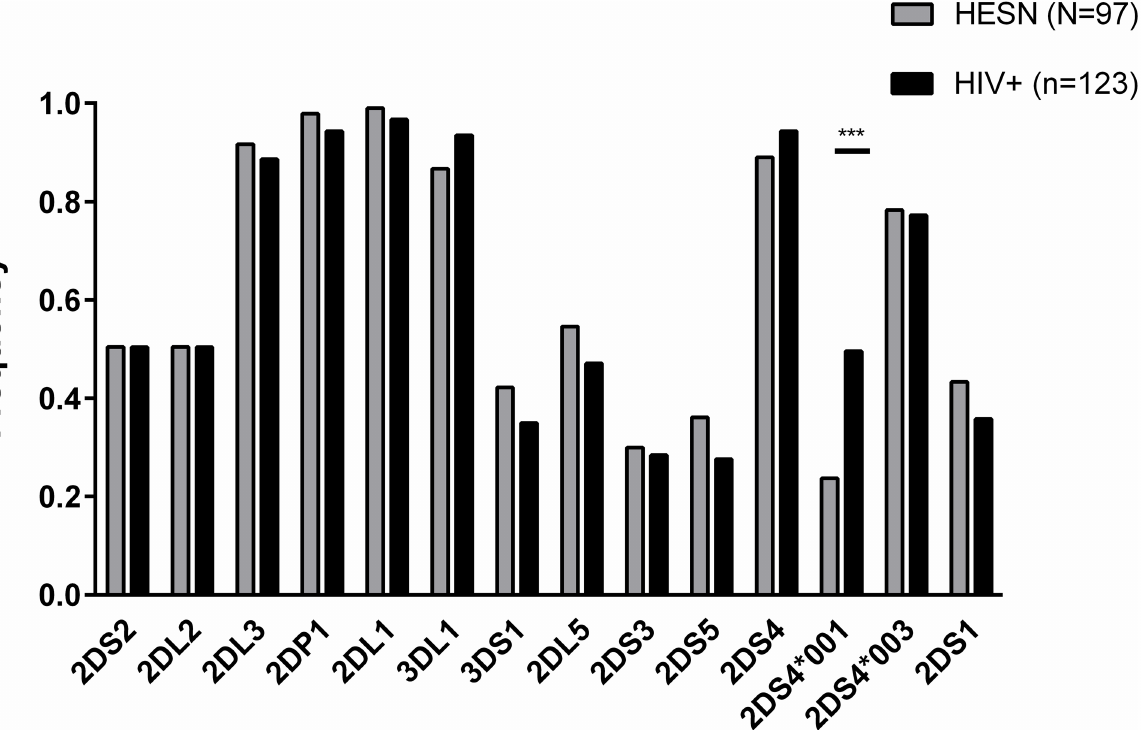
Fig 1. Killer Immunoglobulin-like Receptor (KIR) gene and KIR allele group frequencies in 97 HIV exposed seronegative (HESN) and 123 recently infected HIV positive (HIV+) subjects. Shownon the y-axis are the percentage of HESN and HIV+ individualscarrying each KIR gene. Percentage refers to the numberof subjects positive for each variabledividedby the total number of subjects tested for that variable. The framework genes KIR2DL4 , KIR3DL2 , KIR3DL3 , and the pseudogenes KIR3DP1 were present in all study subjects and are not shown in this this figure. Each gene shown on the x-axis is namedwithout the “KIR” designation, i.e. 2DS1 = KIR2DS2, etc. ** = p’ < 0.01.This p-valuerefers to p-value corrected for multiplecomparisons. This p’-valueis shown over the bar linkingthe 2 groupsbeing